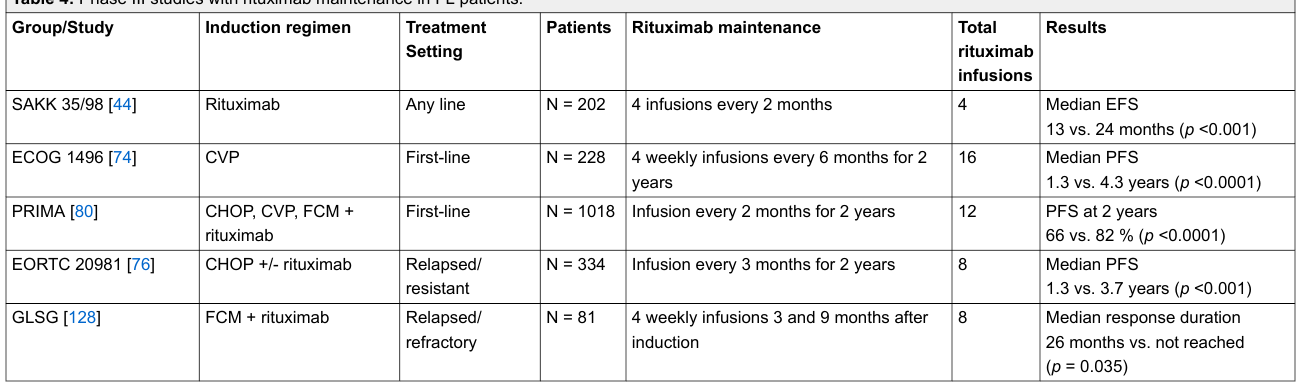
Table 4: Phase III studies with rituximab maintenance in FL patients.